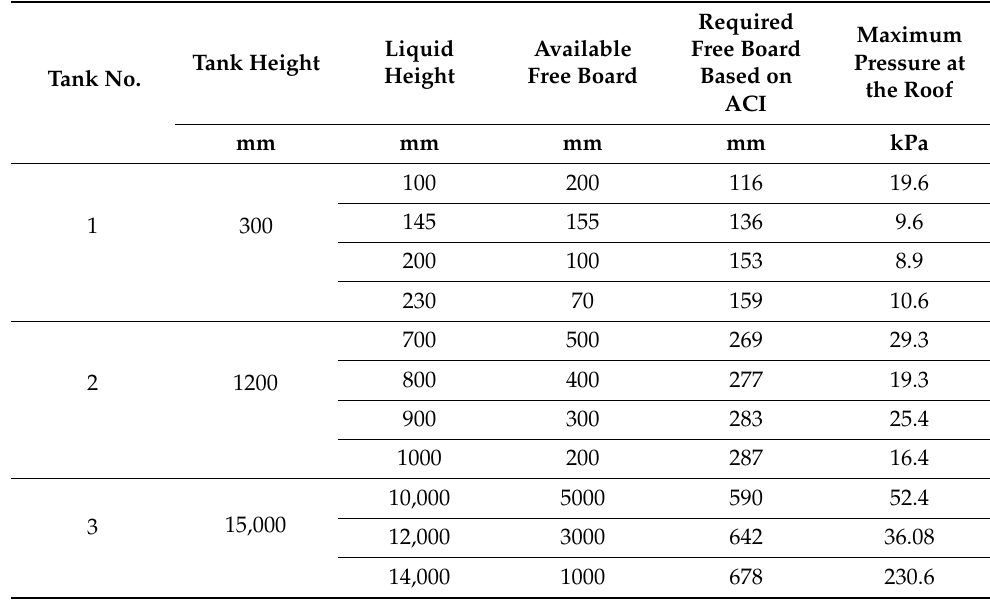
Figure 18. Location of pressure sensors at the roof of the actual-size tank. Table 3. Comparison of available freeboard and the freeboard required by the ACI 350.3-06 and the maximum pressure at the roof with three different tank sizes.